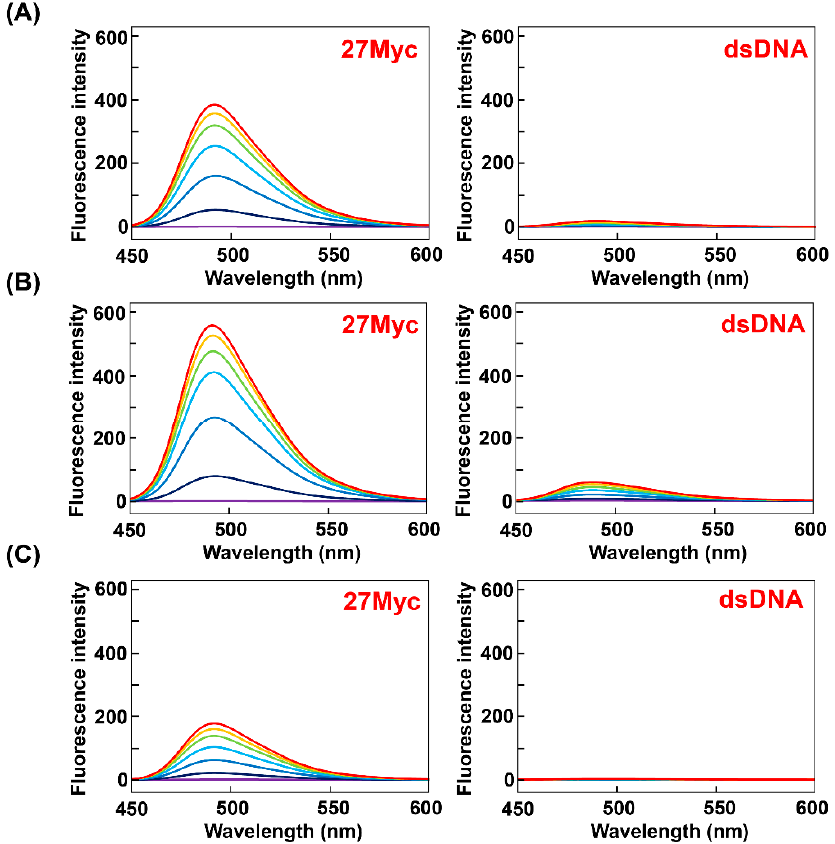
Figure 6. Fluorescence spectra of ( A ) ThT-OE2, ( B ) ThT-SP, and ( C ) ThT-OE11 (3 µ M) in PBS140KM with increasing concentrations of 27Myc (left side) and dsDNA (right side) (0, 1, 3, 6, 9, 12, and 15 µ M). Oligonucleotide concentration: 0 µ M (purple), 1 µ M (navy blue), 3 µ M (blue), 6 µ M (light blue), 9 µ M (green), 12 µ M (yellow), and 15 µ M (red).